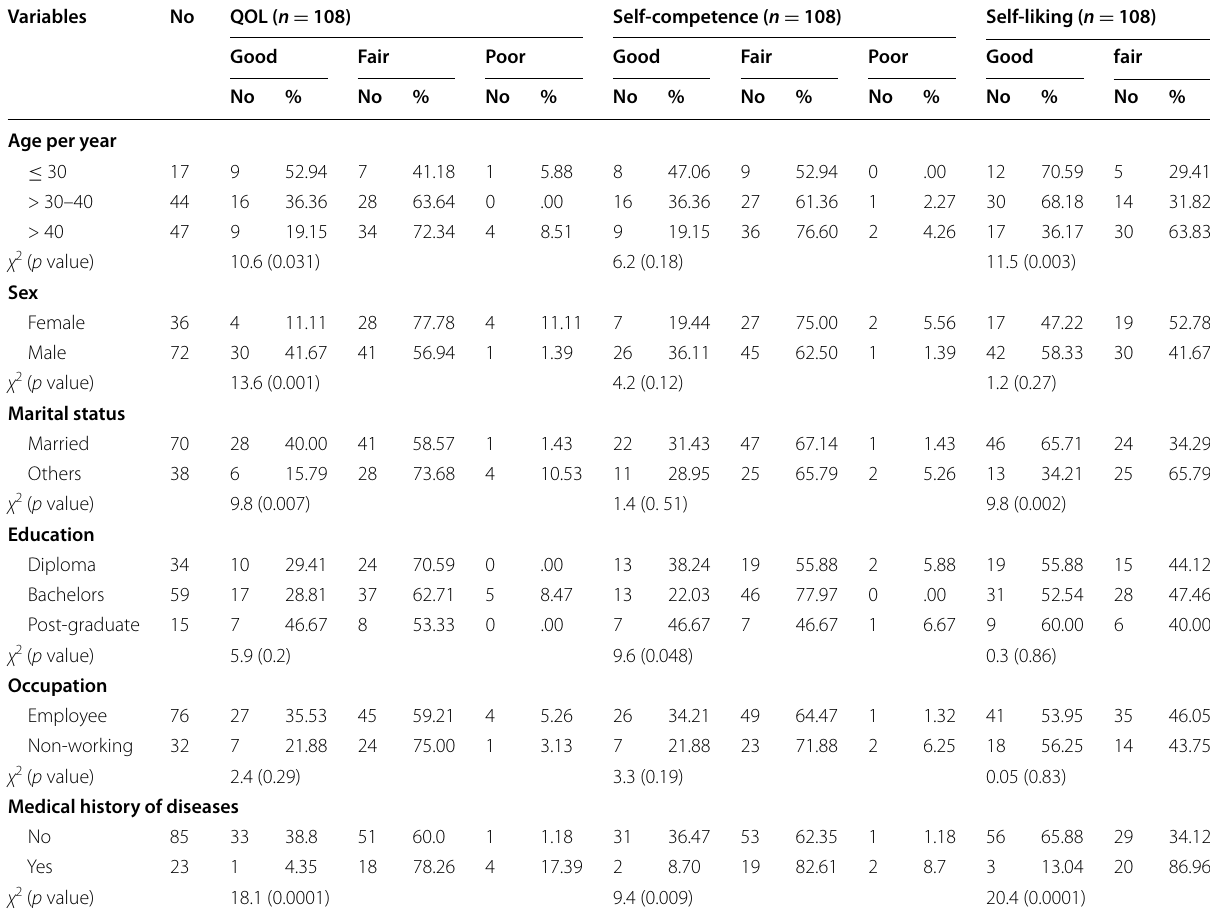
Table 4 Relation between QOL, self‑competence, and self‑liking of caregivers of non‑ADHD children and their socio‑demographic characters ( n 108) =